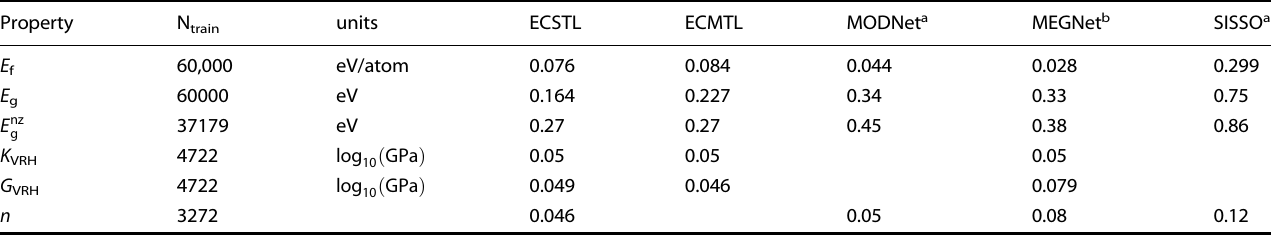
), the bulk modulus ( K VRH ), the shear modulus g